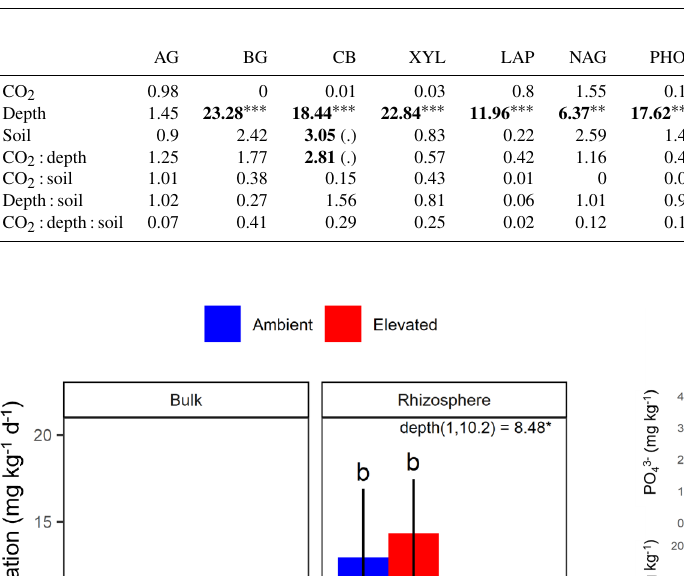
Table 6. Model F statistic and significance levels for potential enzyme activity. The significance of the P values are shown in bold, and asterisks show that ∗∗∗ indicate P< 0 . 001, ∗∗ indicate P< 0 . 01, and ∗ indicates P< 0 . 05. Note that (.) means significant to P < 0 . 1.